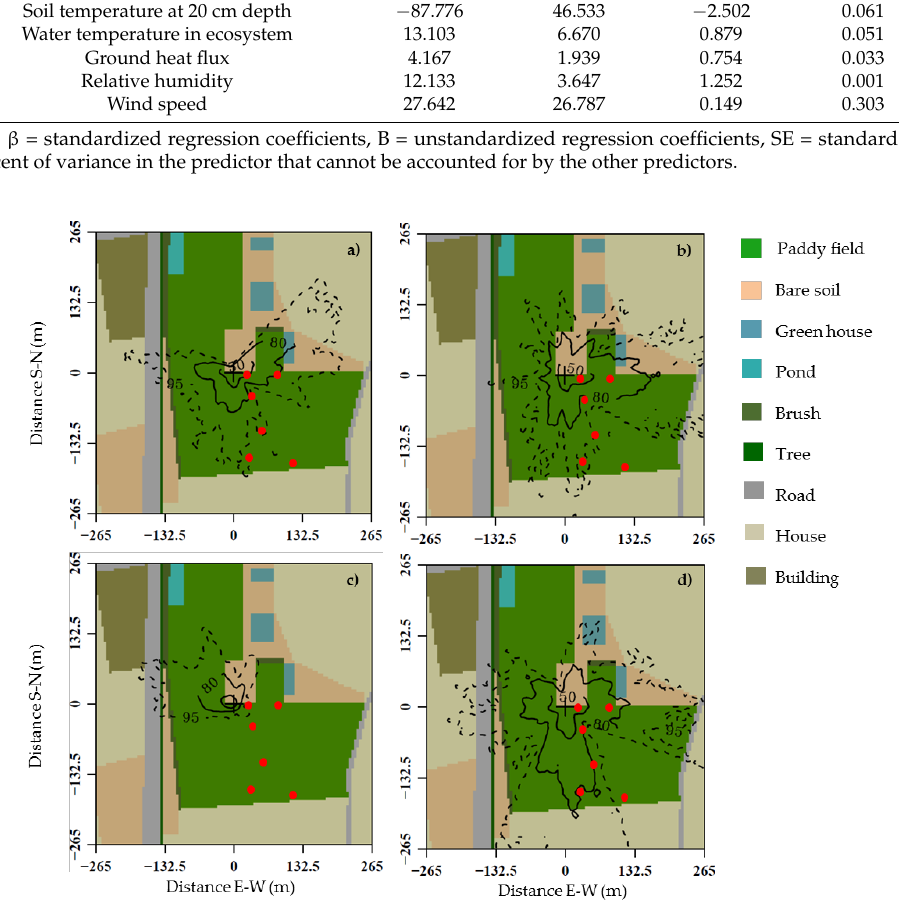
Figure 6. The regimes of atmospheric stability from the footprint analysis model; footprint climatology for all cases at ( a ) 30 DAT; ( b ) 60 DAT; ( c ) 90 DAT; and ( d ) AHV. The cross (+) in the centre marks the eddy covariance tower; the red points represent the sampling points of the closed chamber method. The dashed line indicates the region from which 95% of the flux originated; the solid black line indicates the regions from which 50% and 80% of the flux originated.